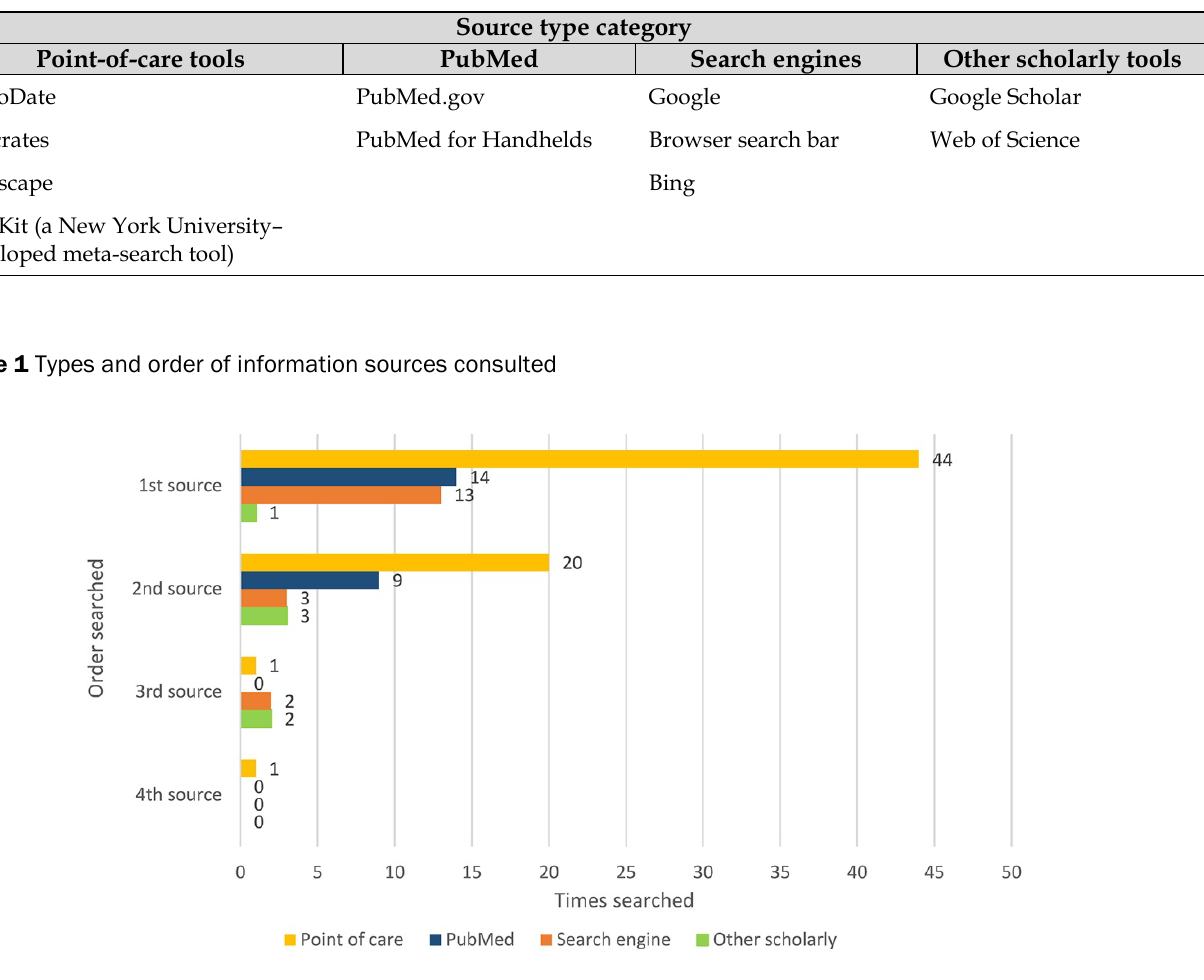
Table 3 Source type categories and included sources